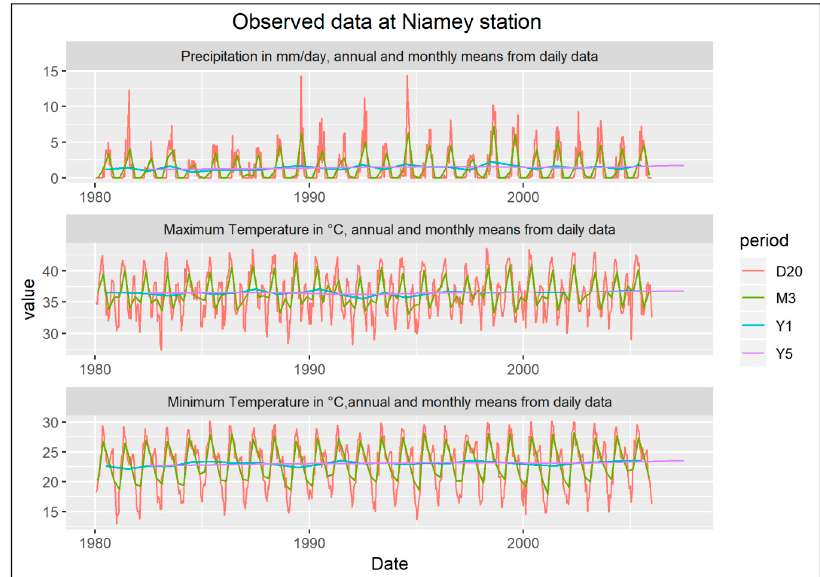
Figure 2. Observed rainfall, maximum temperatures, and minimum temperatures for 1980–2005 at Niamey Airport. Niamey